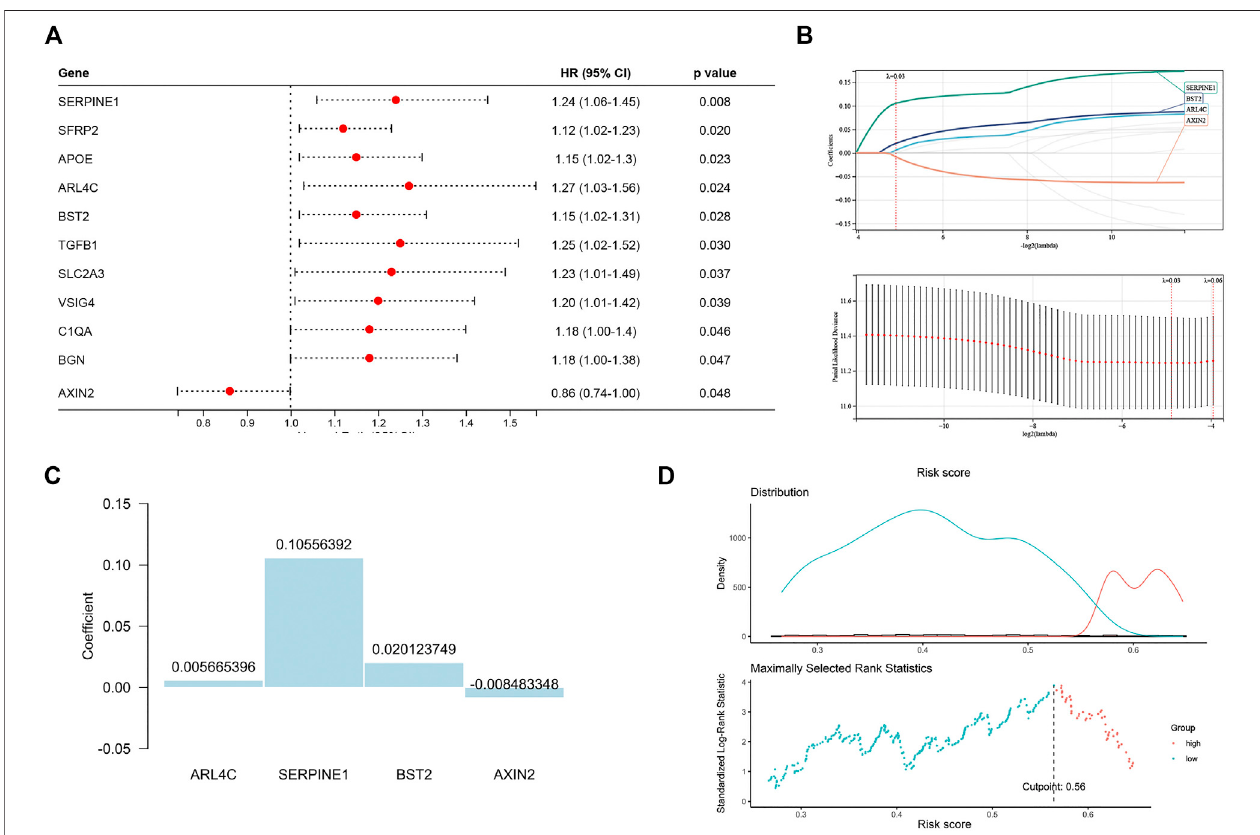
FIGURE6| Constructionofrisksignaturebasedondifferentiallyexpressedgenes. (A) Theforestplotofdifferentiallyexpressedgeneswithprognosticsigni fi cance. (B) The screening of coef fi cients and likelihood deviance under LASSO analysis. (C) The coef fi cients of model genes. (D) Best cutoff value selected by the log-rank test. (E) The relationship between risk score, survival status, and model gene expression. (F) The Kaplan – Meier survival curve showing the difference between high risk and low risk groups in TCGA-COAD. (G) The ROC curves regarding 1-, 3-, and 5-year survival outcomes in TCGA-COAD. (H) The differences in response rates to immune checkpoint blockades between two